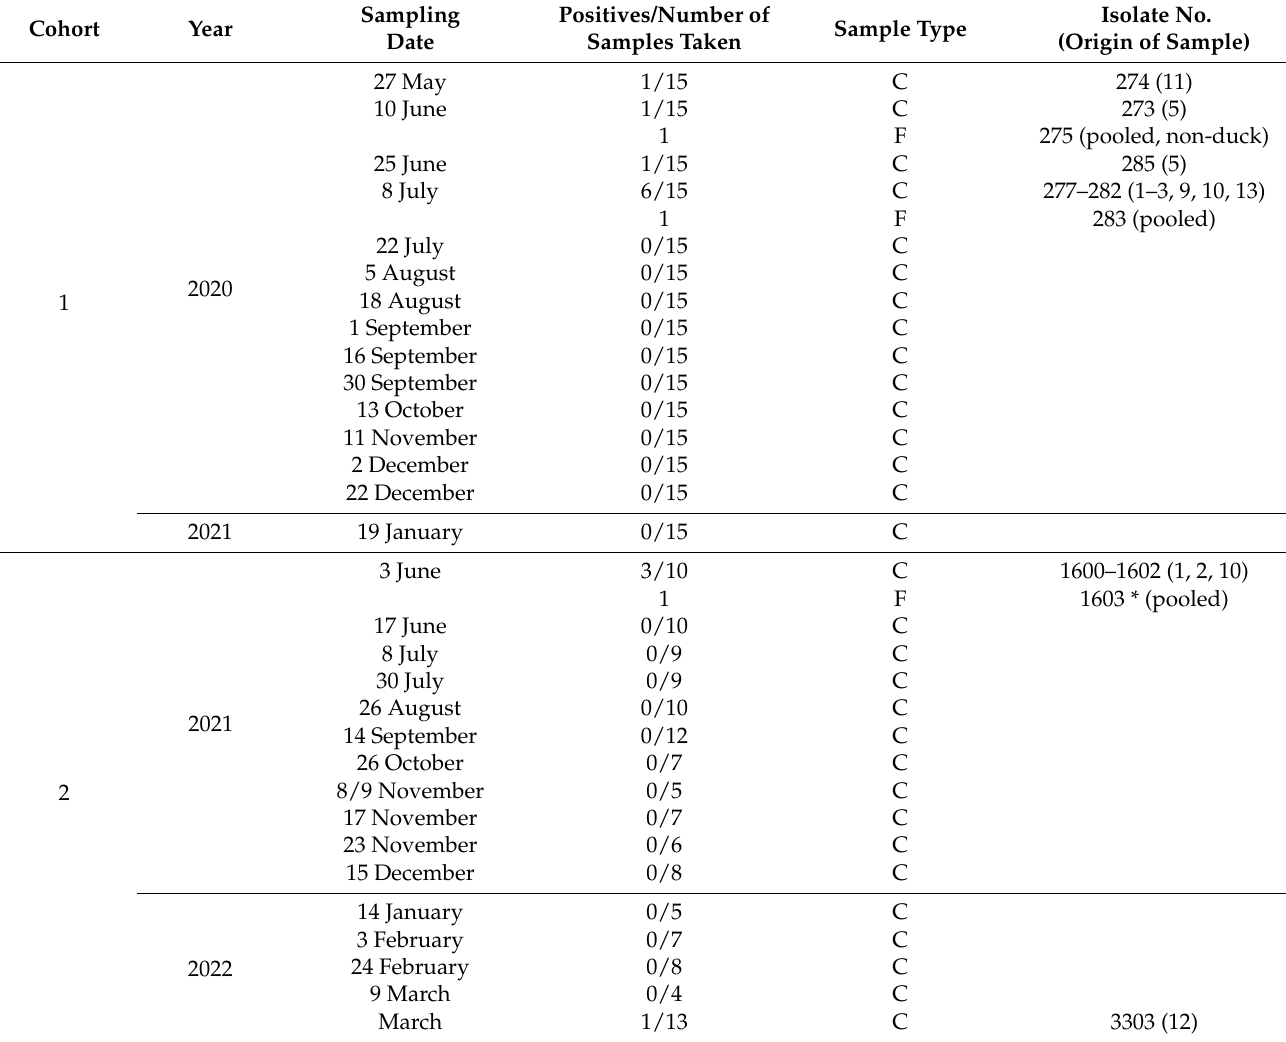
Table 1. Sampling details comprising sample date and sample type. Positive results are connected to their isolate numbers and sample